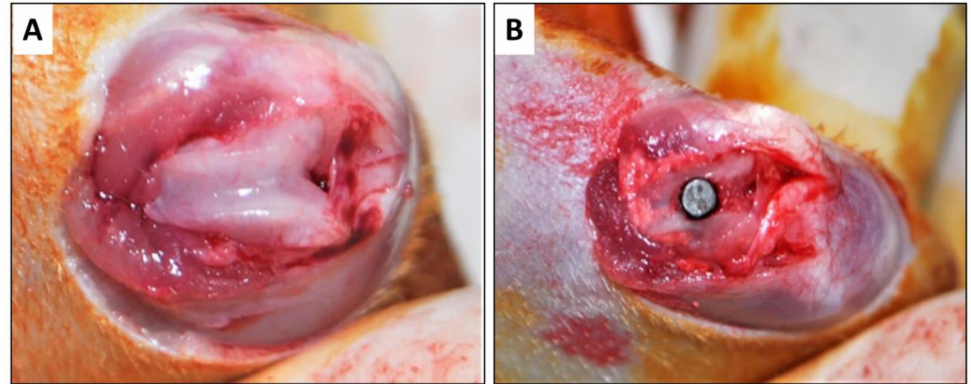
Figure 1. Experimental surgical procedure showing: ( A ) exposure of the intercondylar notch in the distal femur (knee joint region) and ( B ) the titanium implant placed within the prepared hole.